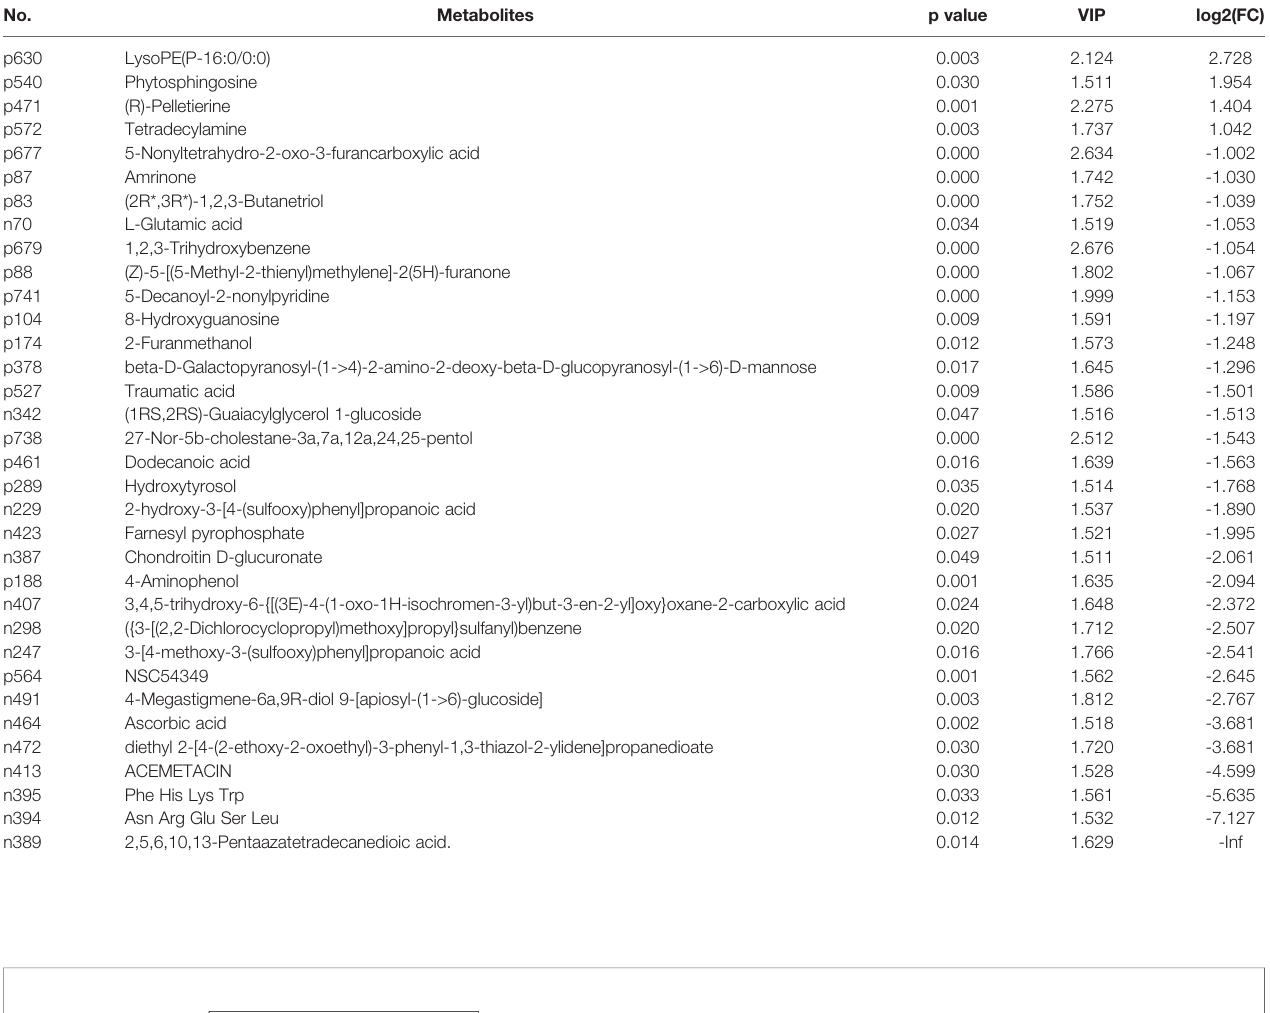
TABLE 2 | Summary of the identi fi ed differential metabolites between IC patients and controls (VIP > 1.5). No.